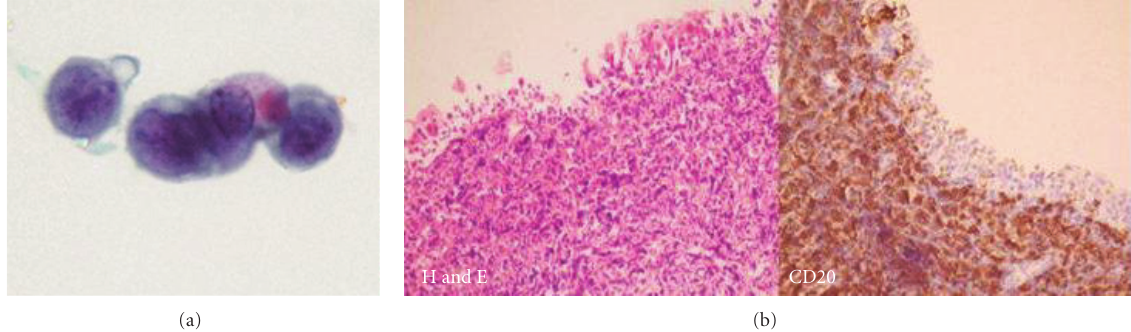
Figure 2: (a) Urine cytology demonstrates a cluster of atypical lymphoid cells. (b) Biopsy of bladder tumour showing infiltration of the transitional epithelium and lamina propria by atypical B lymphocytes (CD20 positive on